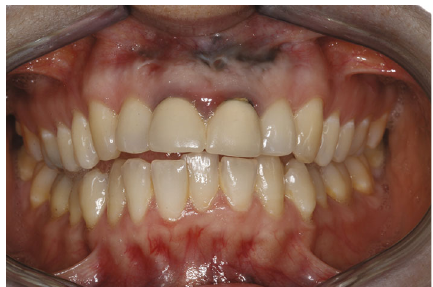
Figure 1: Preoperative clinical view. Note the reddening and in fl ammation at the buccal level of 1.1 and 2.1 and of the interdental papilla, as well as grayish buccal and apical staining of the central incisors, caused by the presence of the silver amalgam fi ller material.